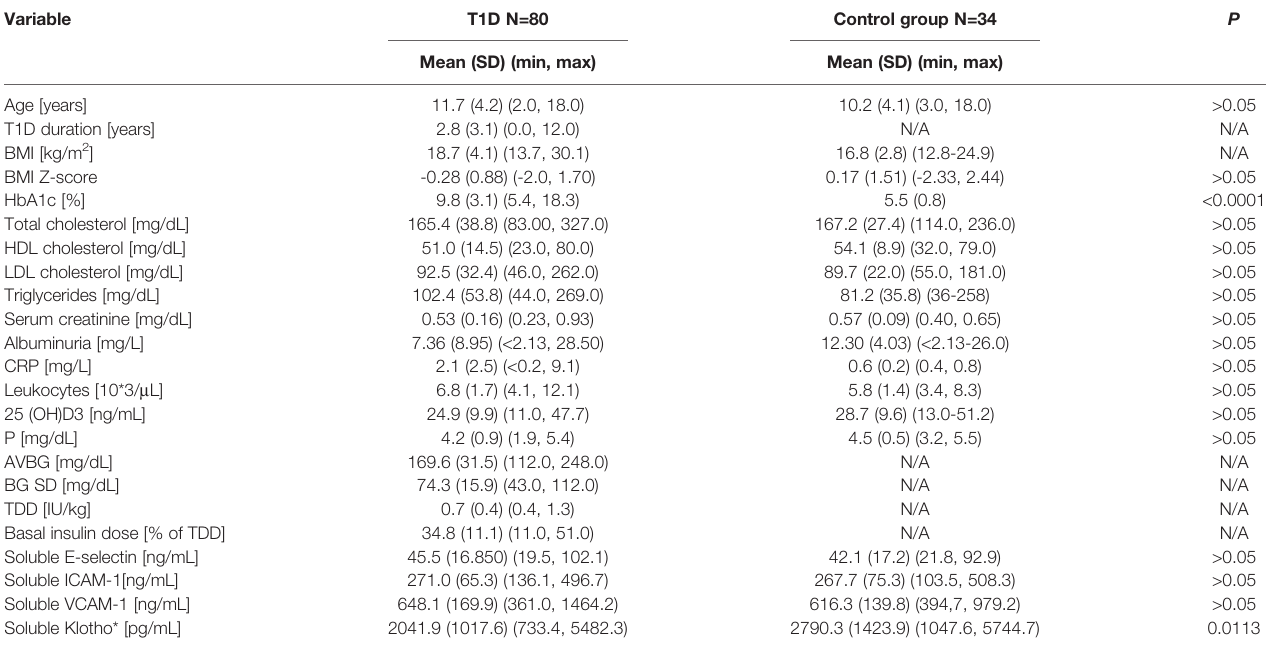
TABLE 1 | Clinical and biochemical features of type 1 diabetes individuals. Variable